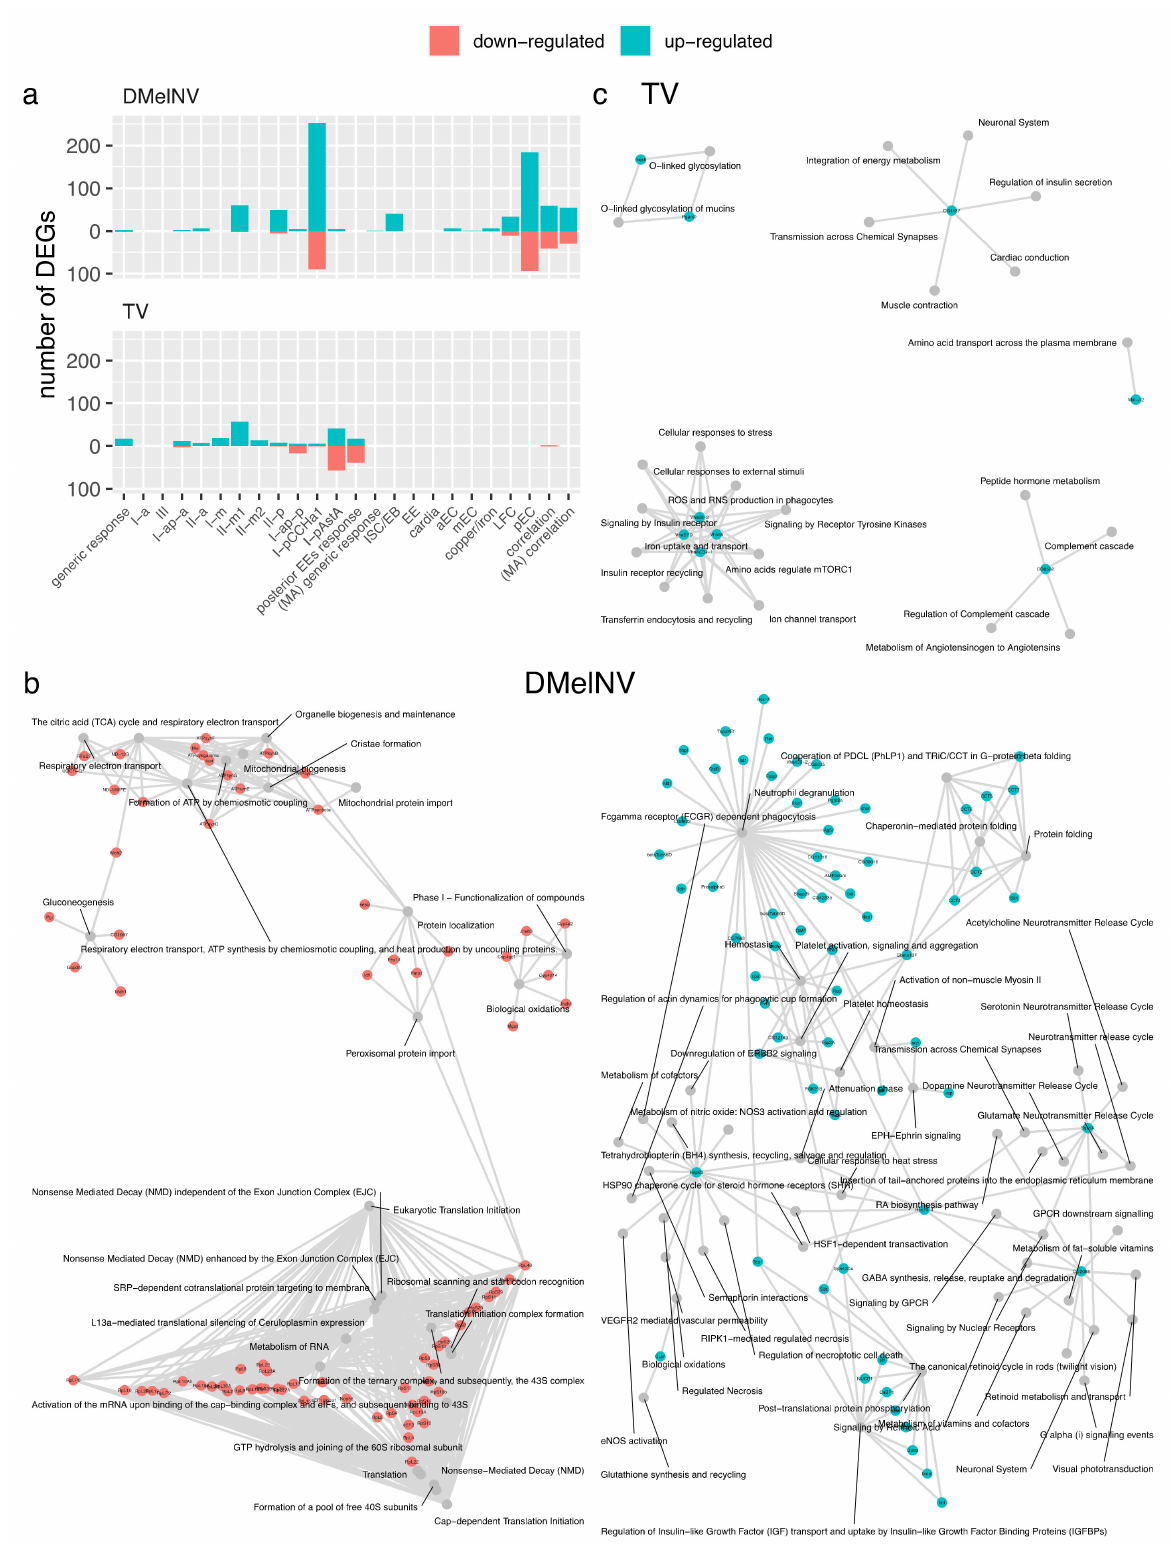
Figure 3. Differential expression and pathway enrichment analyses. ( a ) Number of differentially expressed genes for each generic and cell-subtype-specific test. ( b , c ) Summary of all enriched pathways and its related genes found in the cellular response to TV and DMelNV infection, respectively. Each pathway is represented by a grey node connected to genes found to be differentially